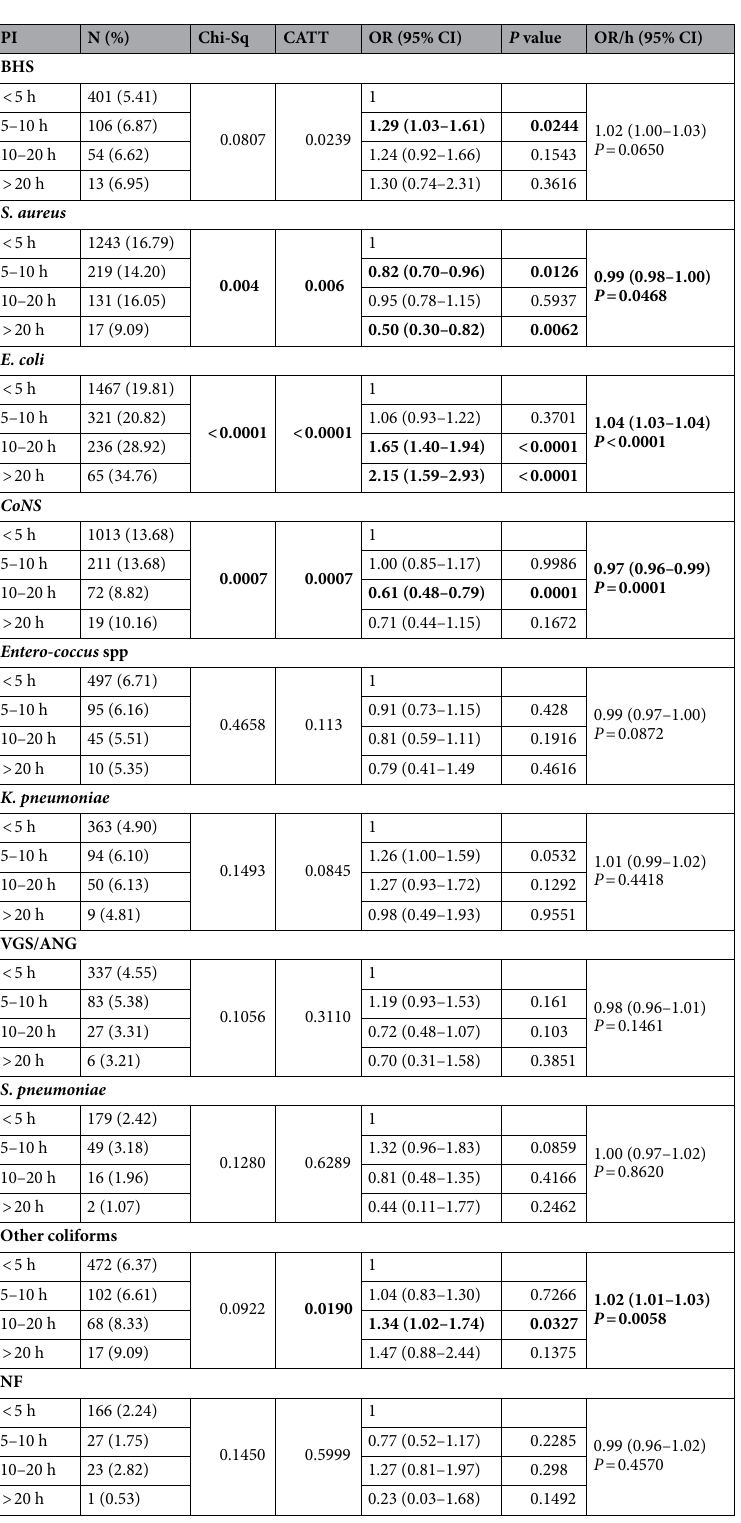
Table 3. Statistical analysis of positivity rates for various bacterial species or groups stratified by preincubation time. P values for Chi-square and the Cochran-Armitage trend test are shown. Logistical regression analysis was performed both with stratified preincubation times, using the < 5 h preincubation group as reference, and using time as a continuous variable. Statistically significant results are bolded. PI: preincubation, CI: confidence interval, Chi-sq: Chi-square, CATT: Cochran-Armitage Trend Test, OR: odds ratio. N: number of isolates, BHS: beta-hemolytic Streptococcus , CoNS: coagulase-negative Staphylococcus , VGS/ANG: viridans group Streptococcus and S. anginosus group, Mn: mean, NF: non-fermenting gram negative bacilli, TOT: